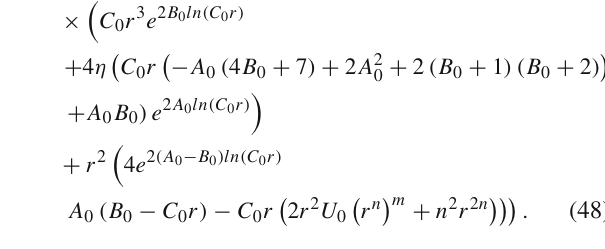
These set of Eqs. (45)–(48) involves some constants A 0 , B 0 and C 0 . The graphical behavior of energy density and